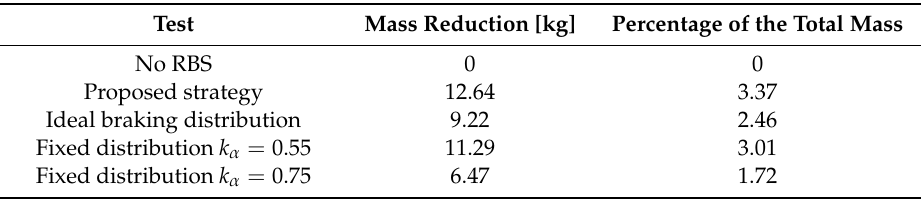
Table 5. Mass saving results.